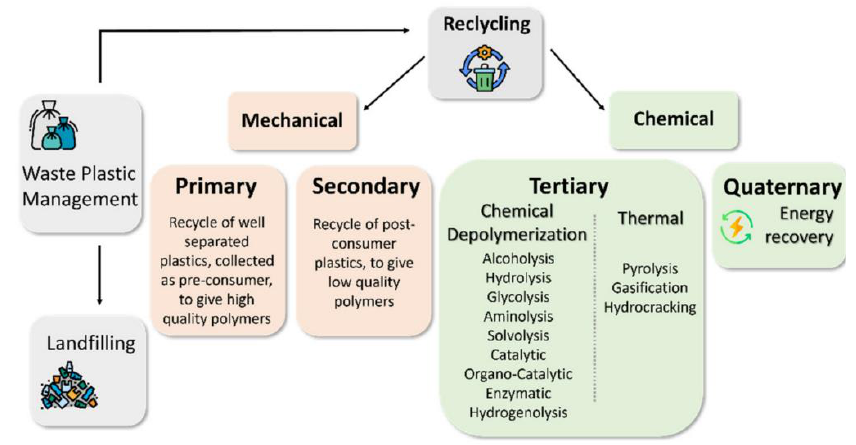
Figure 4. Overview of plastic recycling methodologies. Reprinted with permission from ref. [14].